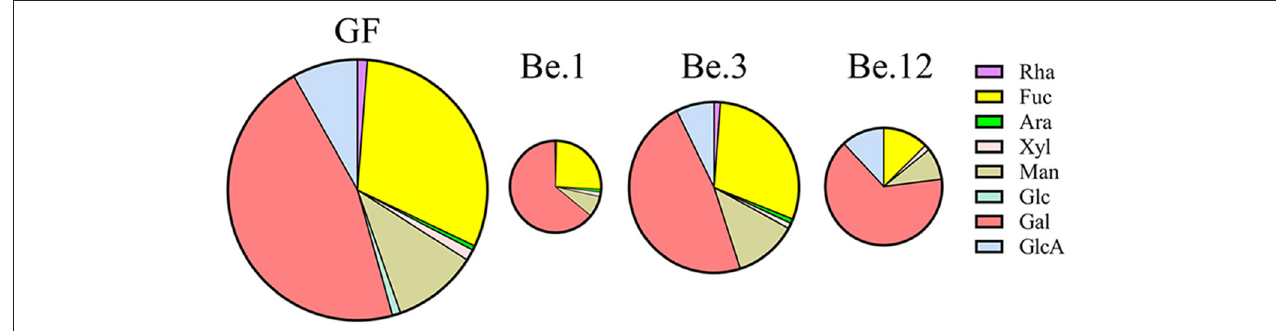
FIGURE 6 | The percentage of monosaccharides in the consumed GF after fermentation by different fecal samples. Be.1, Be.3, and Be.12 were fecal samples obtained from the volunteer Nos. 1, 3, and 12 before the 14-day dietary intake of L. japonica ,